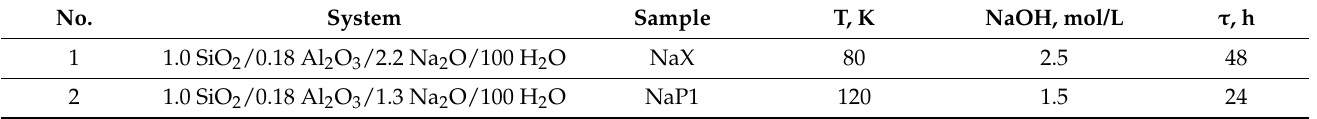
Table 1. Molar compositions of the NaOH-H 2 O-(SiO 2 -Al 2 O 3 ) glass systems and parameters of